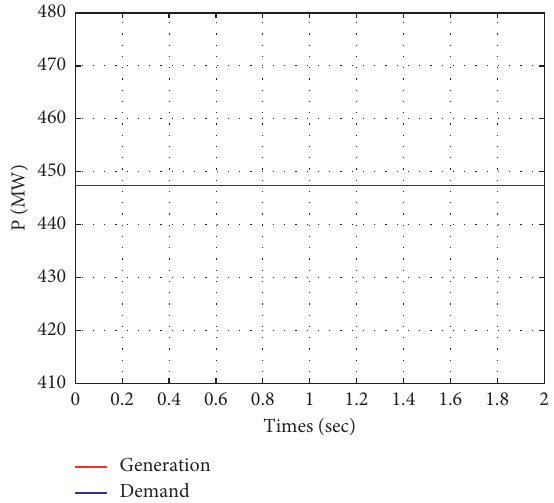
Figure 4: Total power demand of the generator.